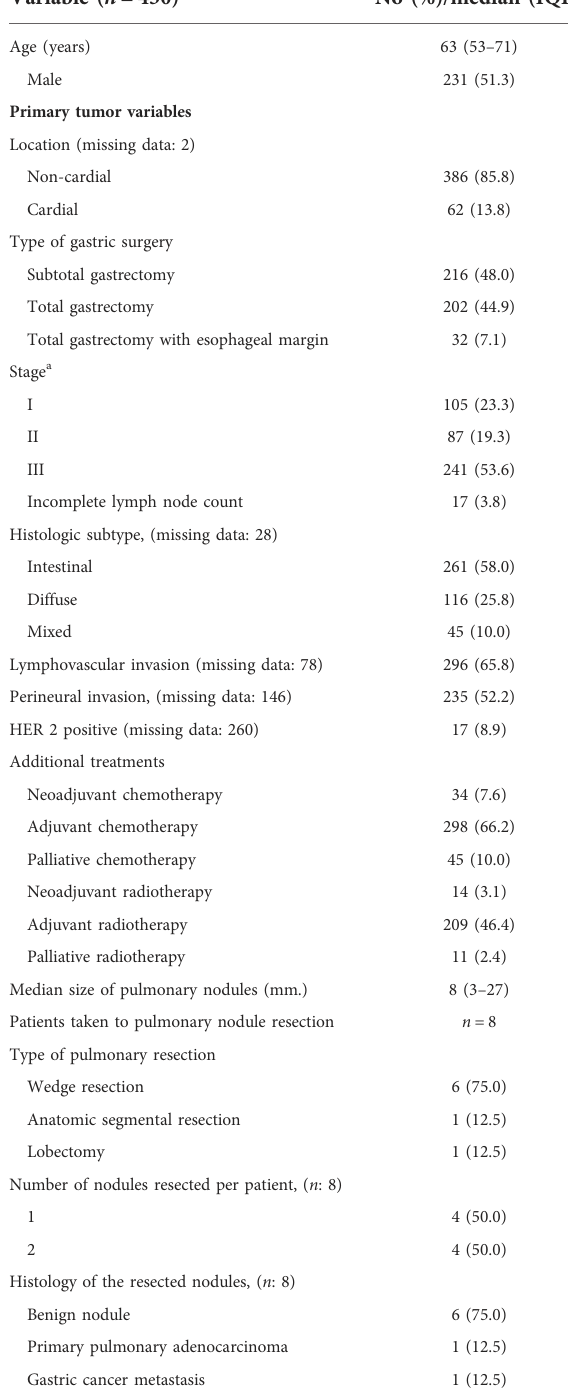
TABLE 1 Demographic, gastric cancer, surgical and follow-up